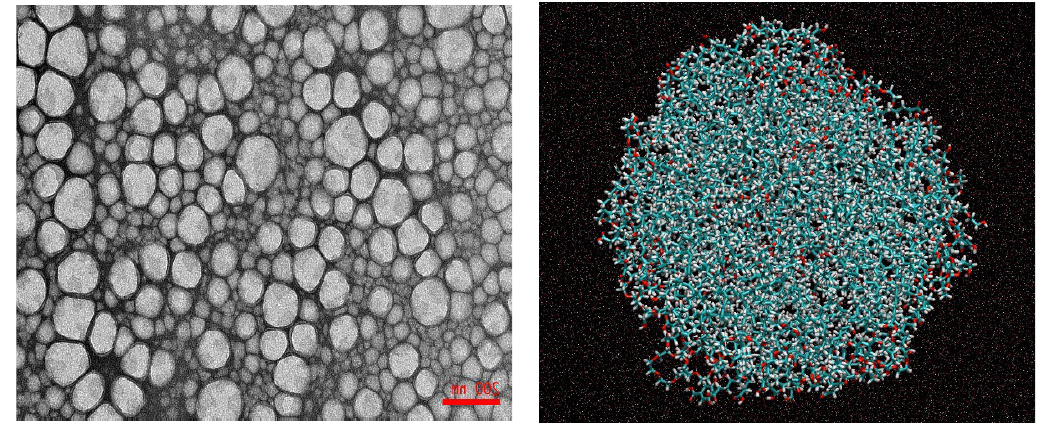
Figure 1. ( Left ) TEM microphotograph (15,000×) of stained (uranyl acetate) 1:9 (v:v) oil-in-water nanoemulsions, stabillized with Tween 80, Φ I = 0.0378. ( Right ) Snapshot of an emulsion droplet obtained through computer simulation (water is omitted for clarity).